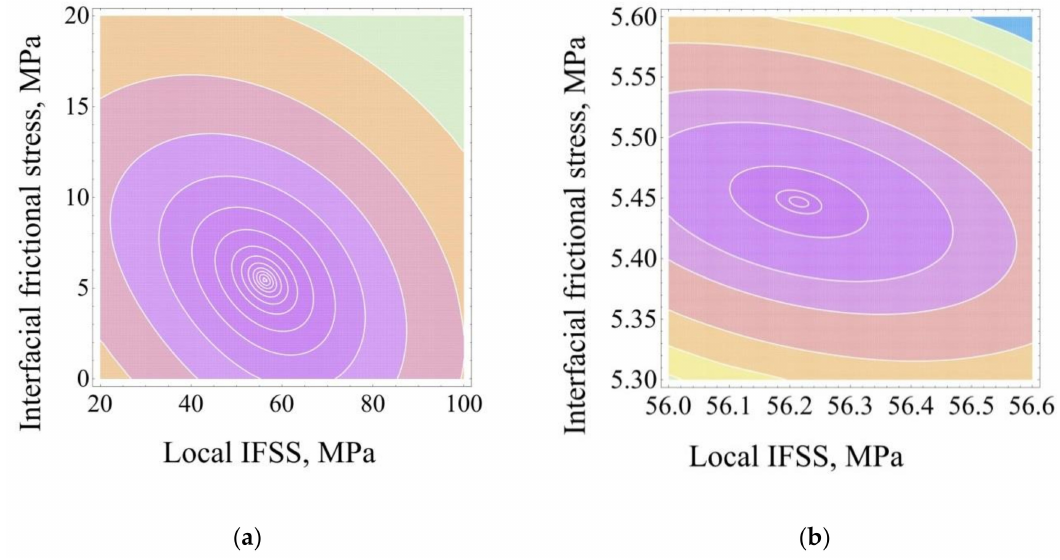
Figure 3. The maps of the sum of least squares for Method 7: ( a ), 1st iteration; ( b ) 3rd iteration. The central point corresponds to the best { τ d , τ f }